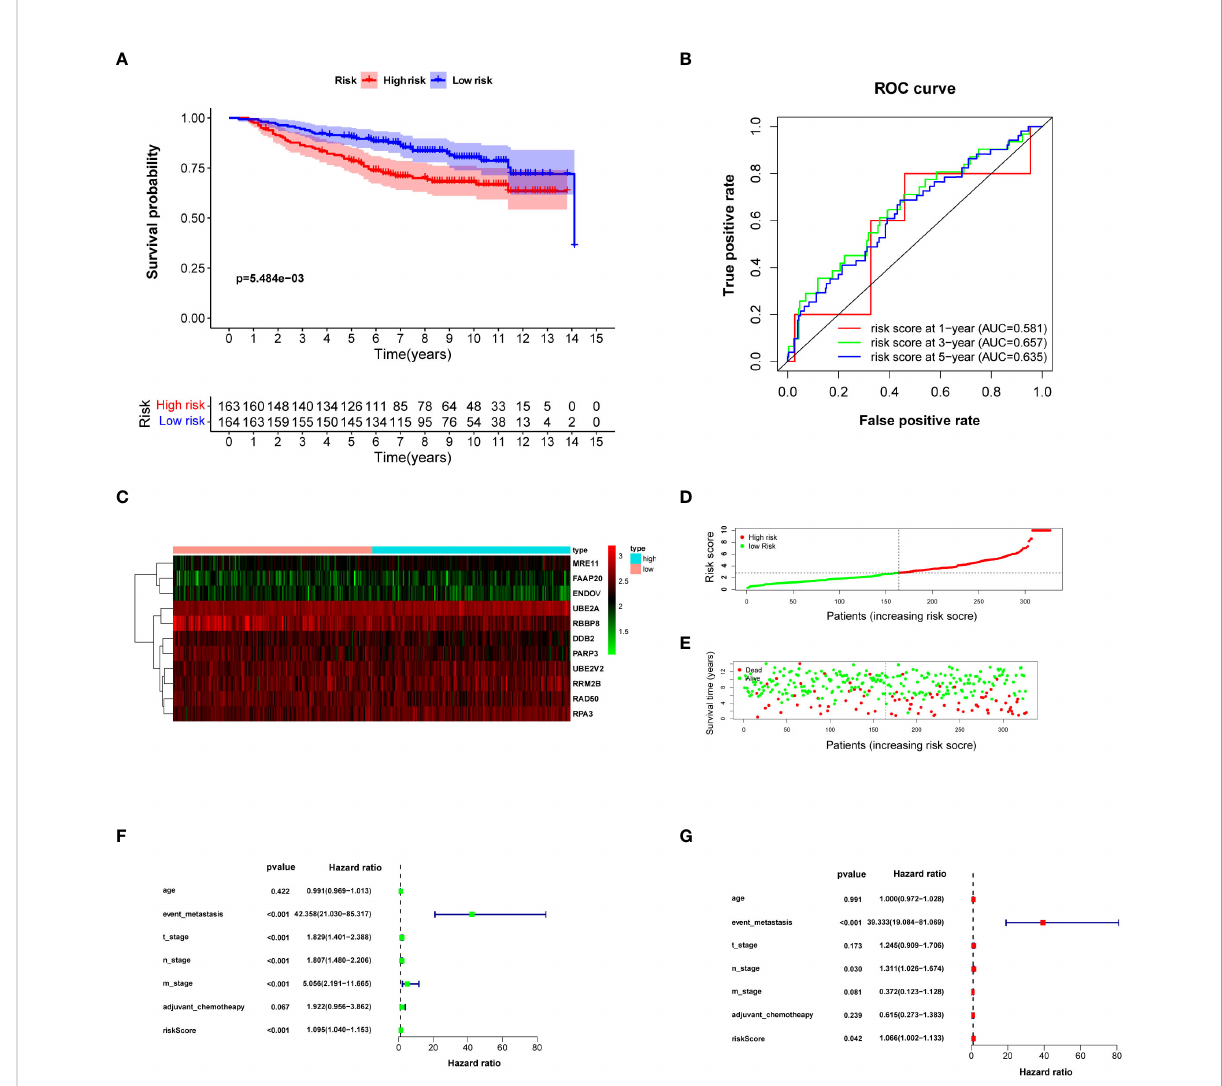
FIGURE 4 Validating risk score calculated by prognosis-signi fi cant DNA repair genes in GSE20685. (A) Kaplan – Meier analysis of patients from the high- and low-risk groups. (B) ROC curve of the risk score in 1, 3, and 5 years. (C) Risk score heatmap of 10 prognosis-related DNA repair genes; the expression level of eight DEGs increased with color varied from green to red. (D) Risk score scatter plot of the high-risk and low-risk patient groups. (E) The dotted line displays the individual in fl ection point of the risk score curve. (F, G) Forest plot of univariate and multivariate Cox regression for prognosis indicators including risk